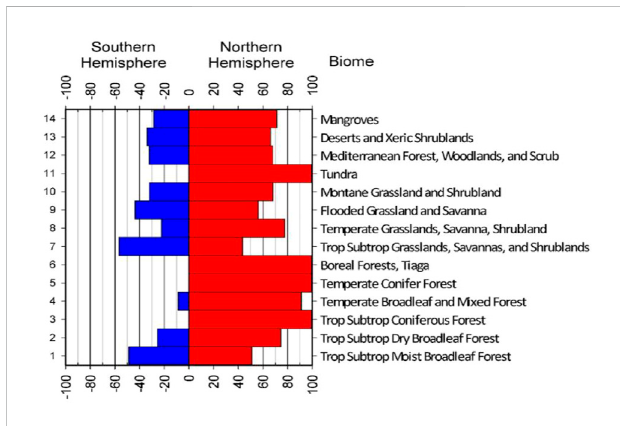
FIGURE 8 Percentage of global biomes by their hemispheric and latitudinal distribution for the 14 biomes under